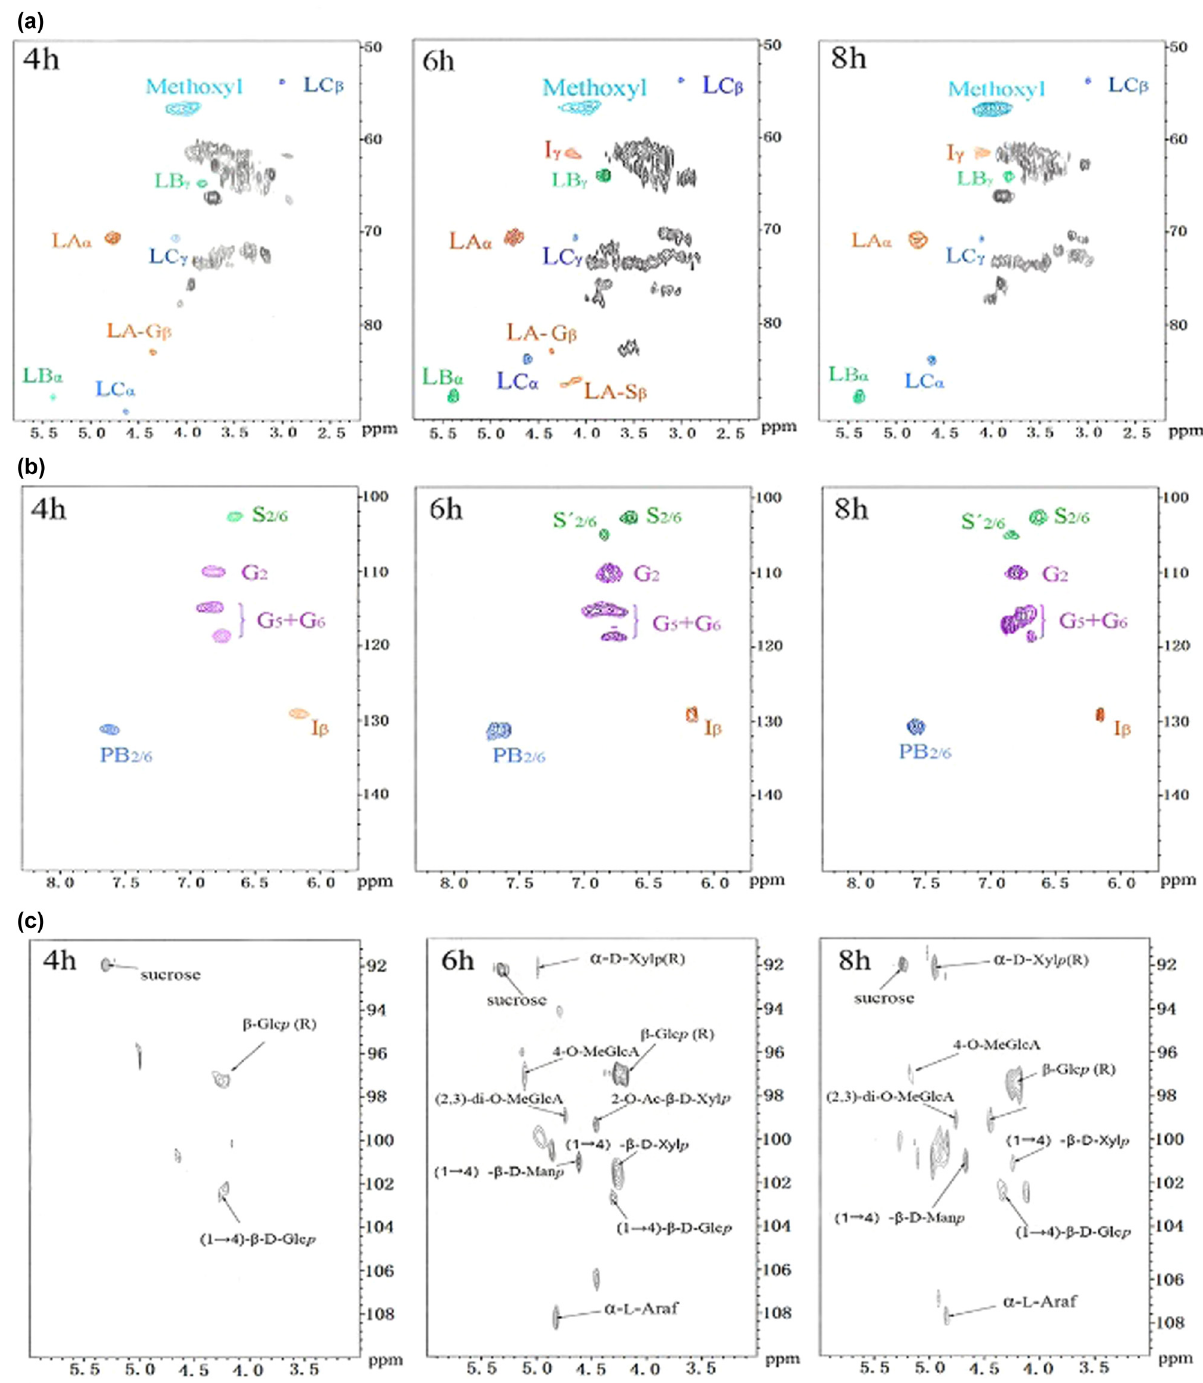
Figure 5: 2D HSQC NMR spectra of ball - milled tobacco leaf cell walls at di ff erent milling times: ( a ) lignin side - chain and polysaccharide regions, ( b ) aromatic regions, and ( c ) anomeric